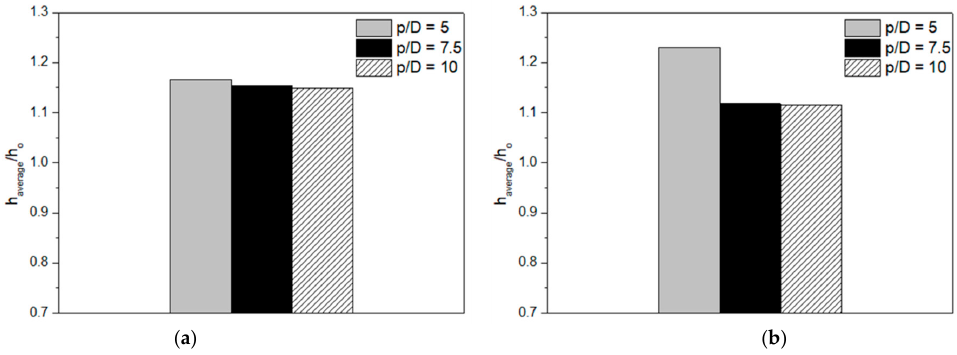
Figure 9. h average /h o for different hole pitch cases: ( a ) M = 1.0; and ( b ) M = 2.0.